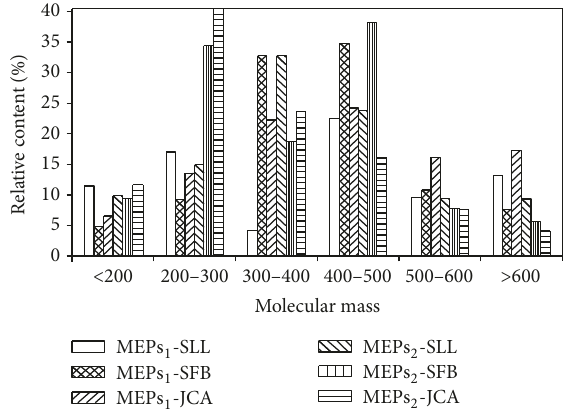
Figure 5: Distributions on molecular mass of the compounds identified with